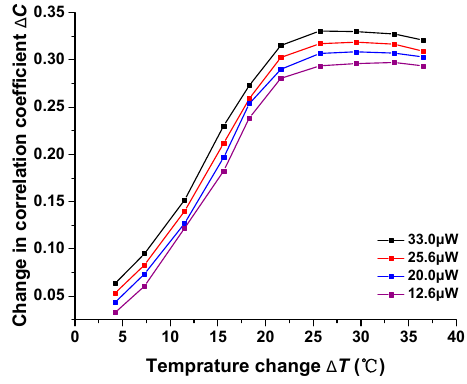
Figure 6. Temperature response under different laser powers.